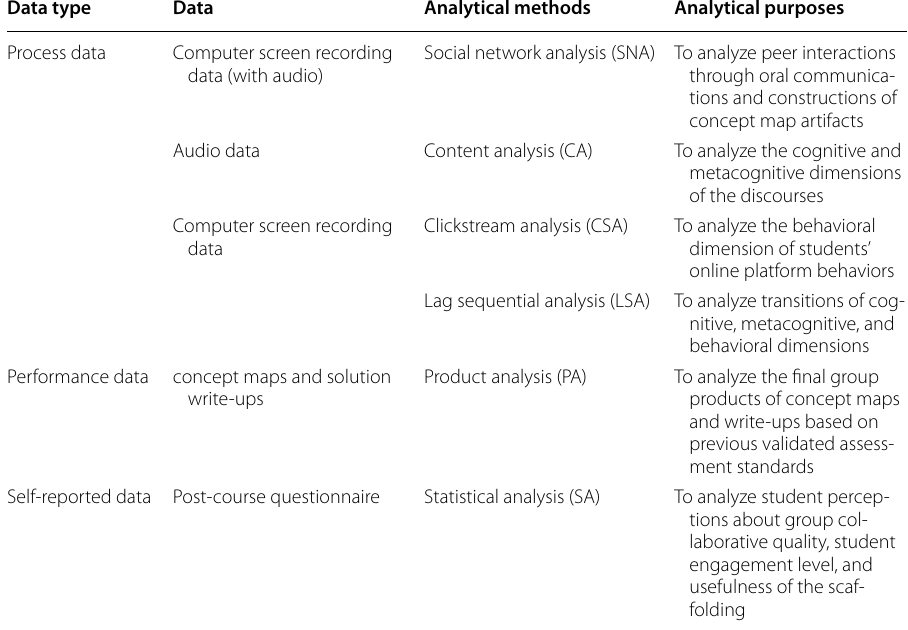
Table 2 The overall analytical framework Data